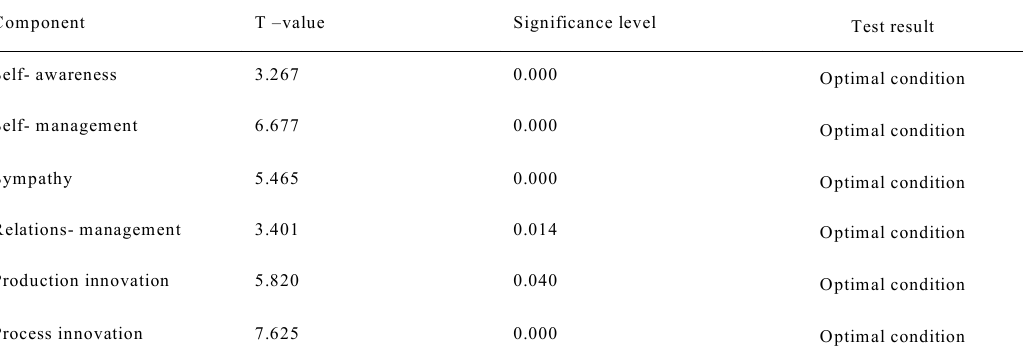
Table 3: Results of single sample T- test